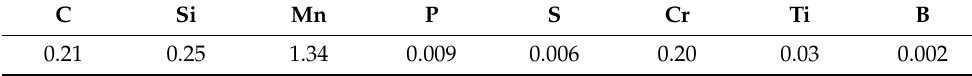
Table 1. The composition percentages of the as-delivered 22MnB5 boron steel sheet (in wt. %).